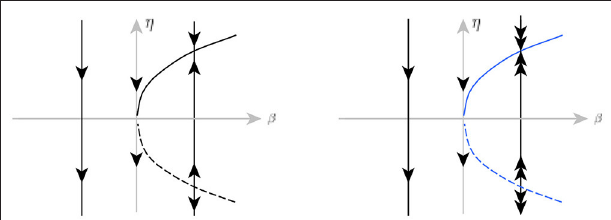
FIGURE 3 | The equilibrium fold bifurcation (left) and the singularity fold bifurcation (right) in normal form (Equations 11, 12), respectively, where we have taken s = − 1 in both